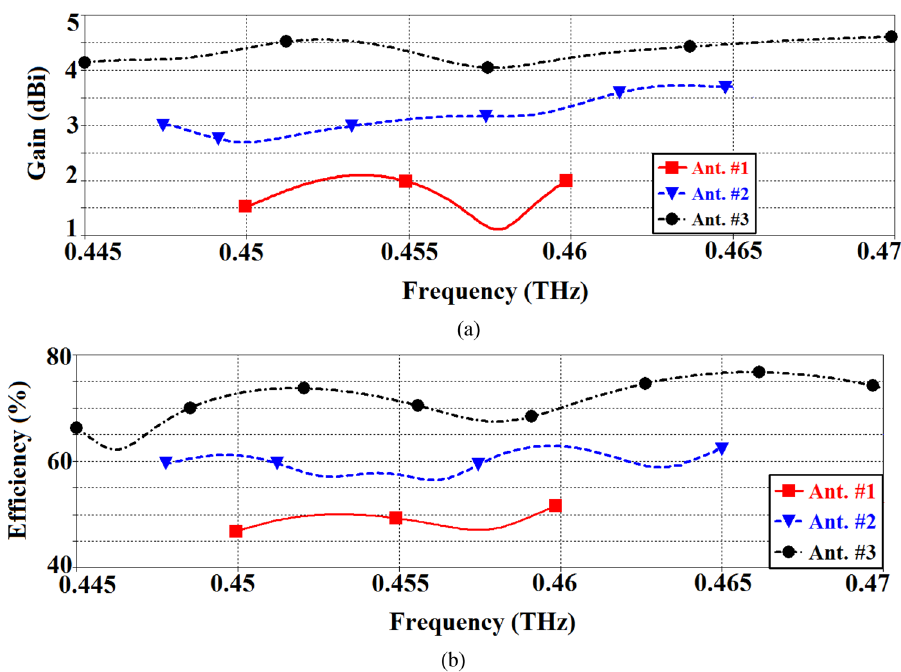
Figure 10. Comparison of the antenna gain and radiation efficiency response of Ant. #1 (SIW), Ant. #2 (SIW- MTS), and Ant. #3 (SIW-MTS with feedline MTS and short-circuited feedline ends).